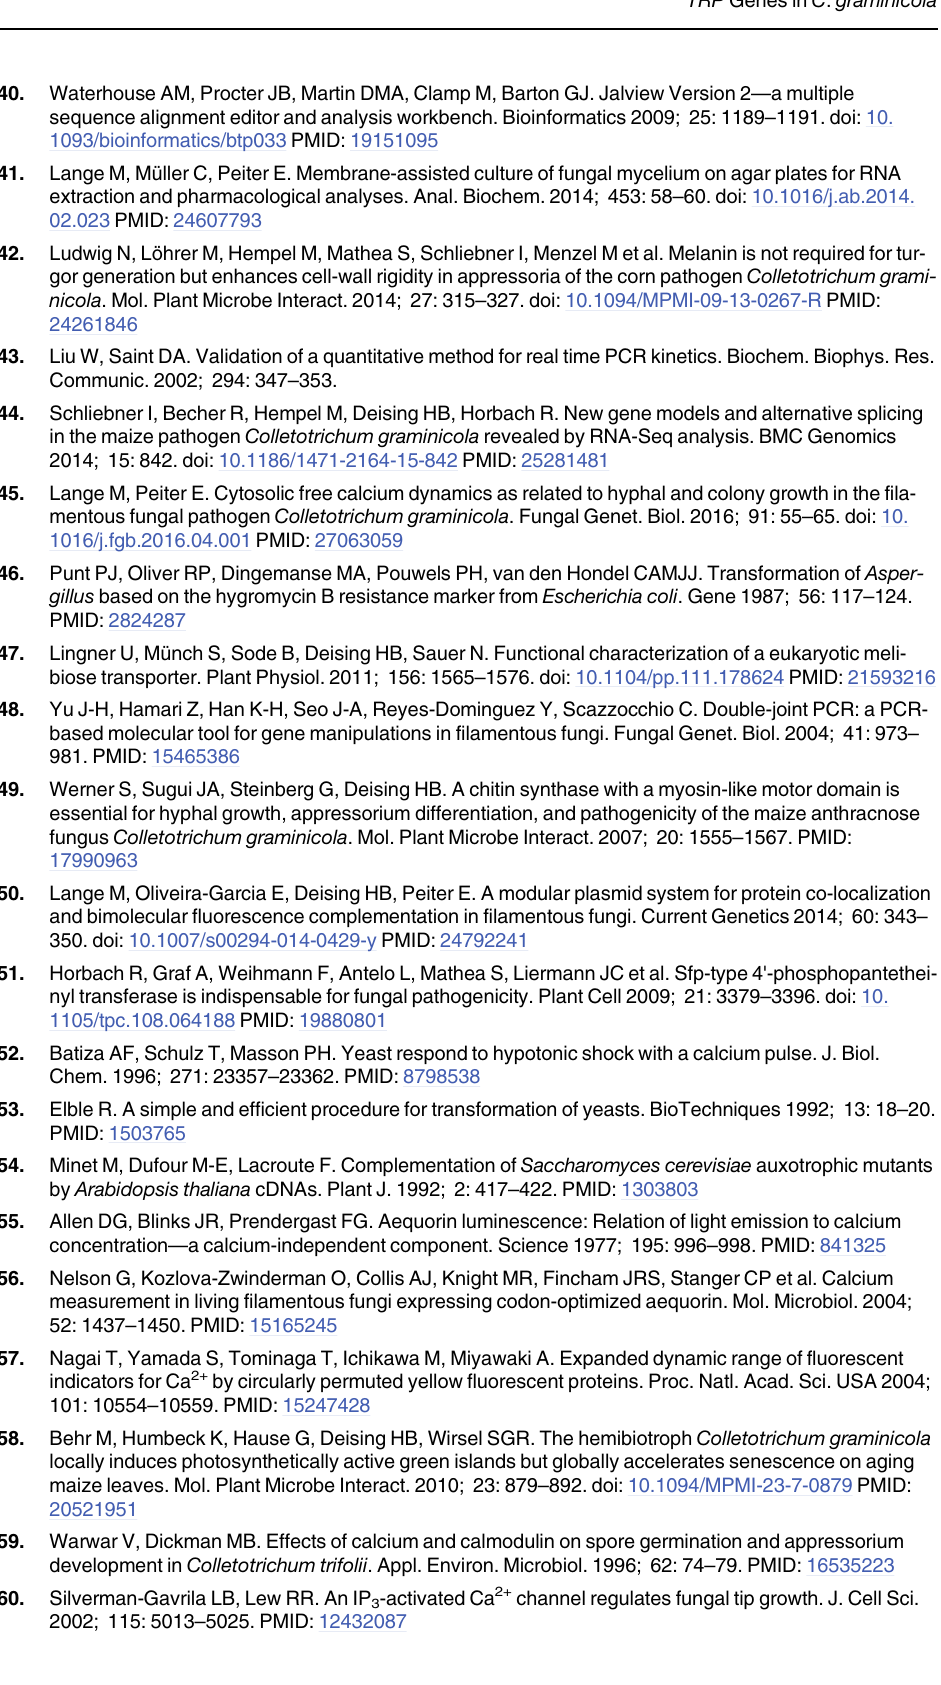
PLOS ONE | DOI:10.1371/journal.pone.0158561 June 30,